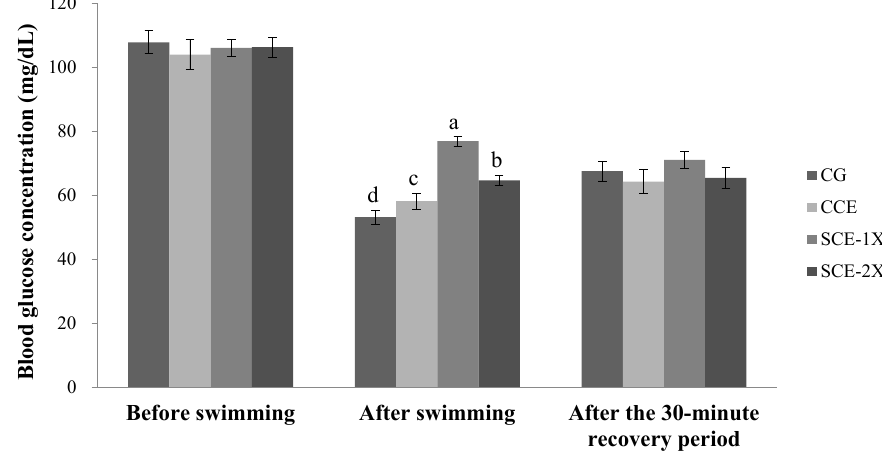
Figure 2. The effect of different treatments on the blood glucose concentration in mice. Values are means±standard deviation for n = 8 mice per group. CG, control group; CCE, commercial dripped chicken essence; SCE-1X, spent hen dripped chicken essence; SCE-2X, double dosage of spent hen dripped chicken essence. a-d Bars with different letters are significantly different at p<0.05.